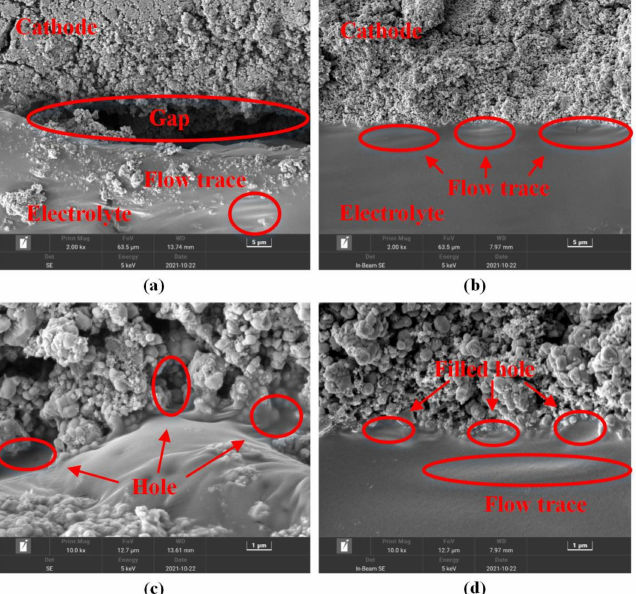
Figure 7. Electrolyte/cathode interface morphologies from: ( a ) Hot-pressed Group, 2000 × ; ( b ) Ultra- sonic Group, 2000 × ; ( c ) Hot-pressed Group, 10,000 × ; ( d ) Ultrasonic Group, 10,000 ×